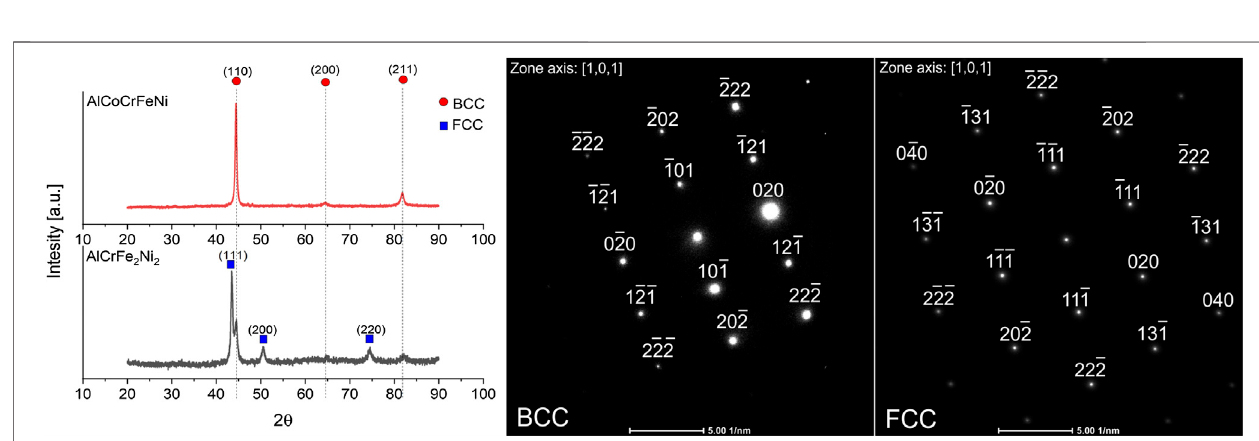
Figure 6B . Compared with STS, the quinary alloy, FCC, rich